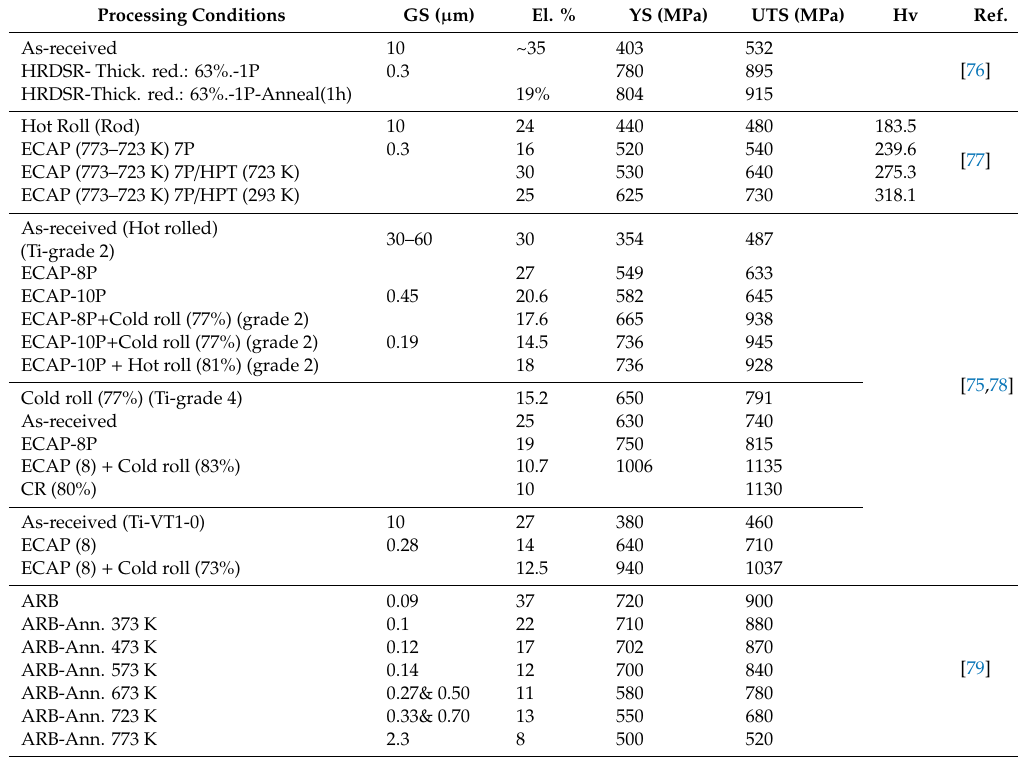
Table 2. Comparison between the mechanical properties of pure Ti obtained from HRDSR and other processing routes. Here, GS is the grain size, El., YS and UTS are the tensile elongation, yield strength and ultimate strength, respectively, and Hv is the Vickers